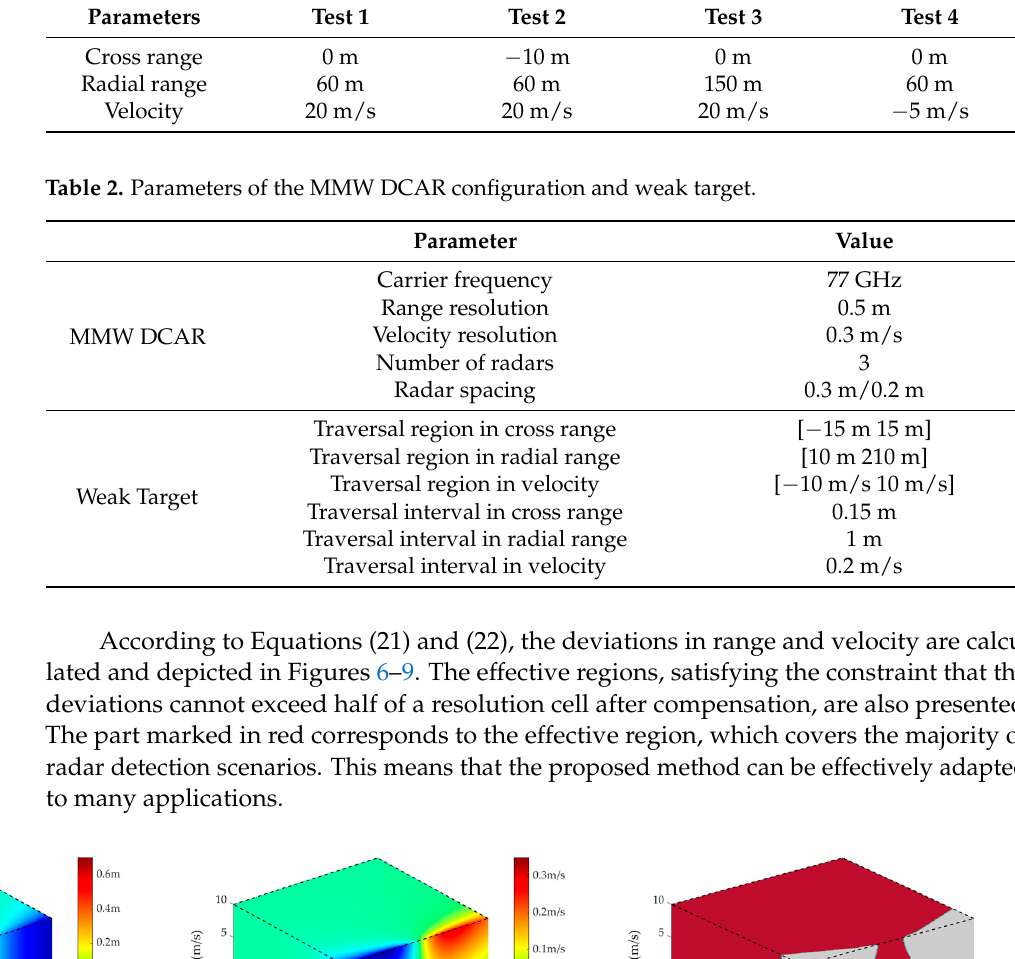
( c ) Figure 7. The simulation results of Test 2. ( a , b ) display the range and velocity deviations. ( c ) represents radar detection scenario, including effective region (red) and ineffective region (gray). ( a ) ( b ) ( c ) Figure 8. The simulation results of Test 3. ( a , b ) display the range and velocity deviations. ( c ) represents radar detection scenario, including effective region (red) and ineffective region (gray).